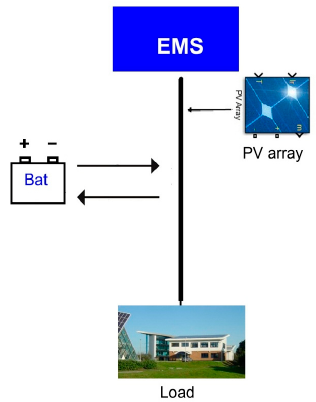
Figure 4. Microgrid test scheme.